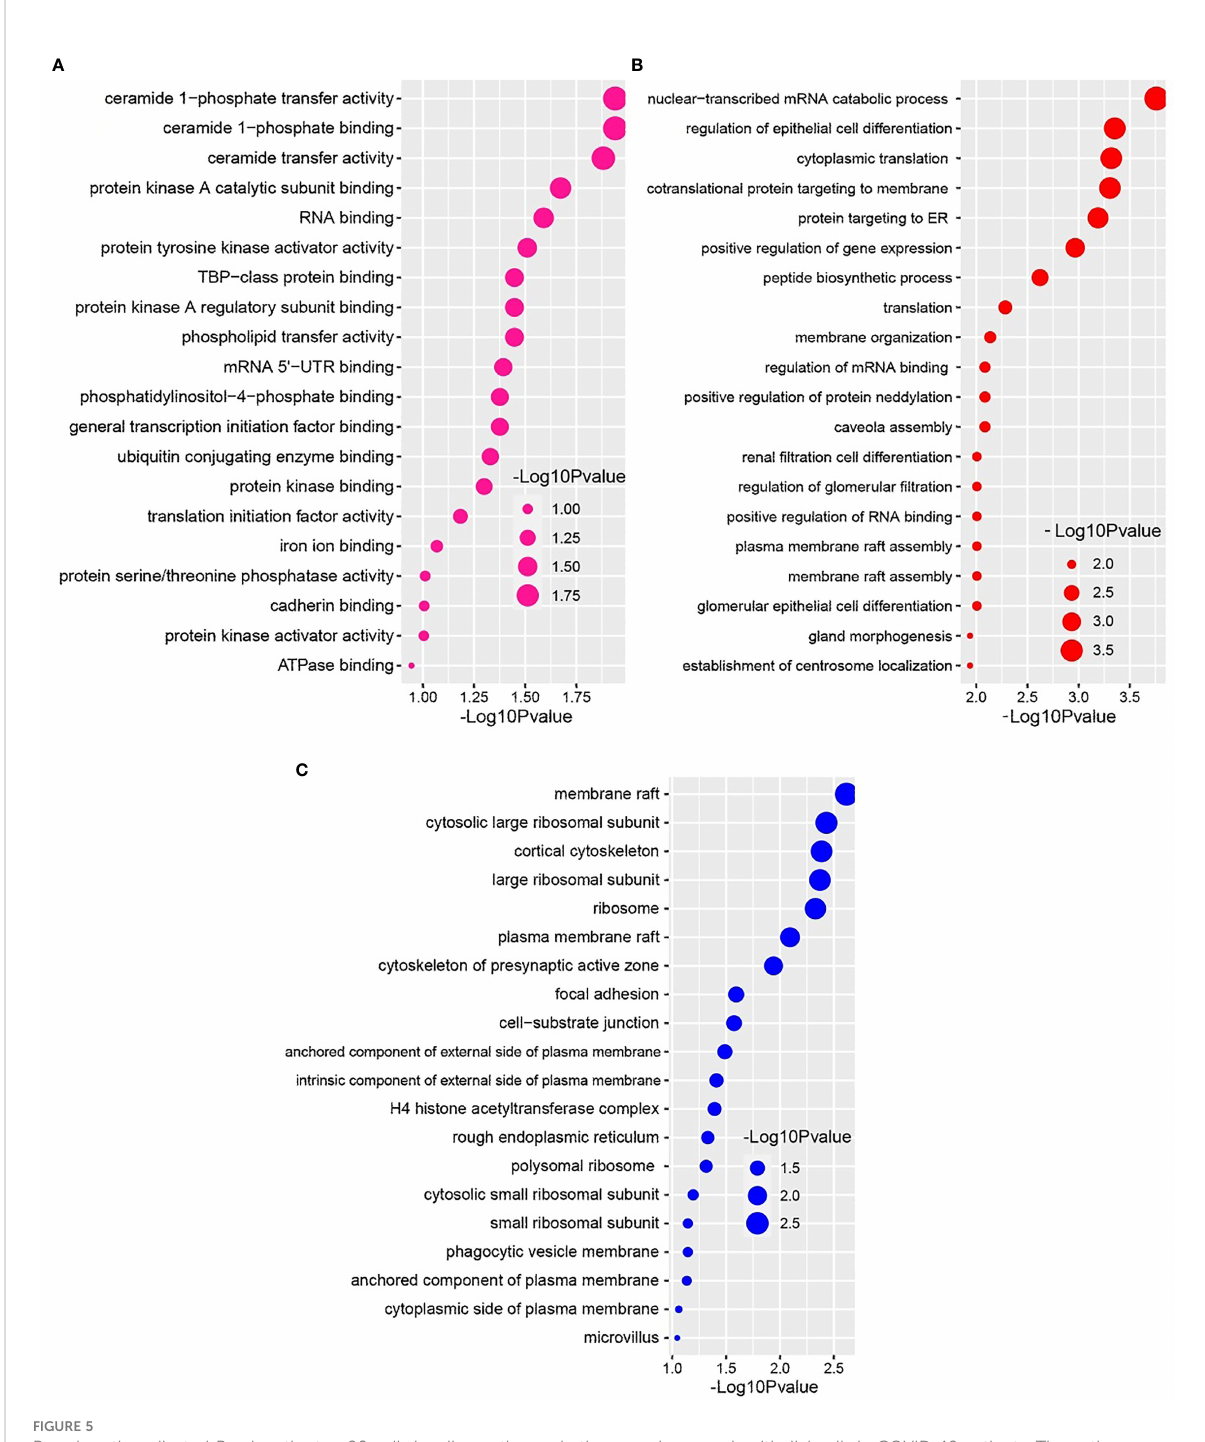
FIGURE 5 Based on the adjusted P -value, the top 20 cell signaling pathways in the nasopharyngeal epithelial cells in COVID-19 patients. The pathways have been formed by combining the DEGs that are common in the (A) gene ontology (GO) molecular function, (B) GO biological process, and (C) GO cellular